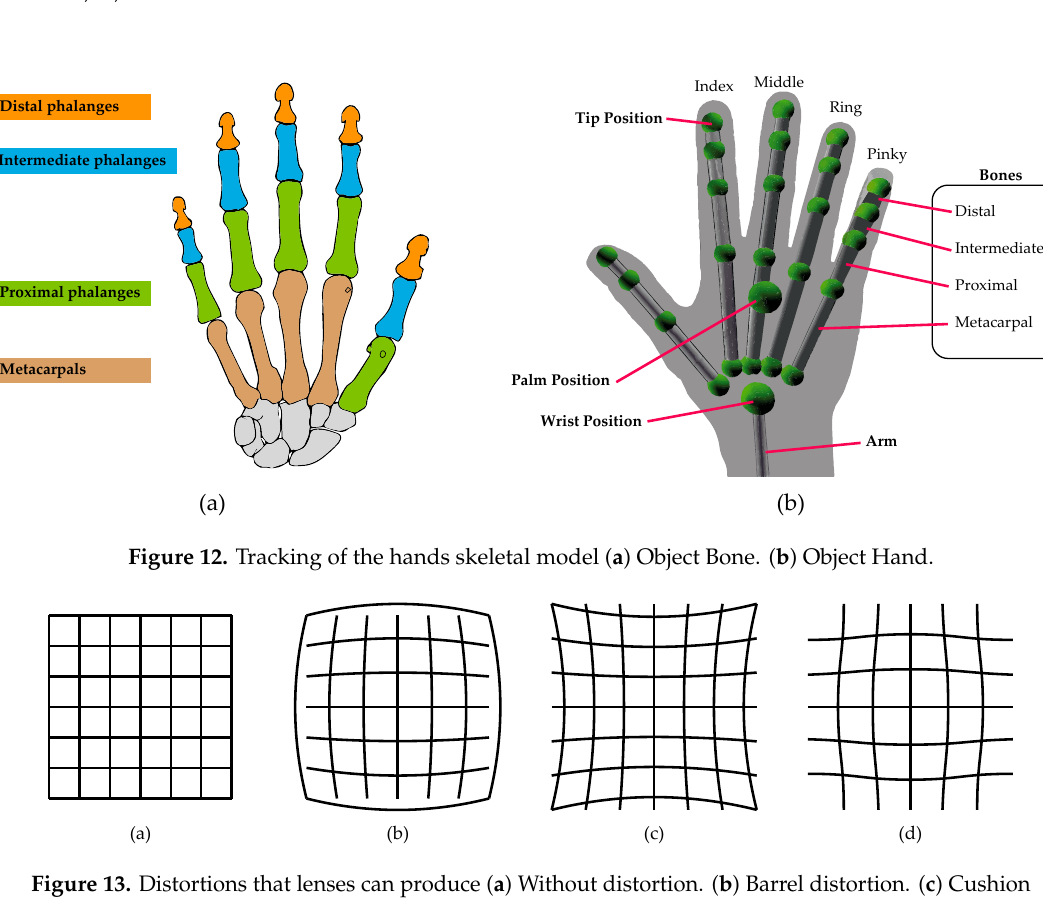
Figure 13. Distortions that lenses can produce ( a ) Without distortion. ( b ) Barrel distortion. ( c ) Cushion distortion. ( d ) Complex distortion.